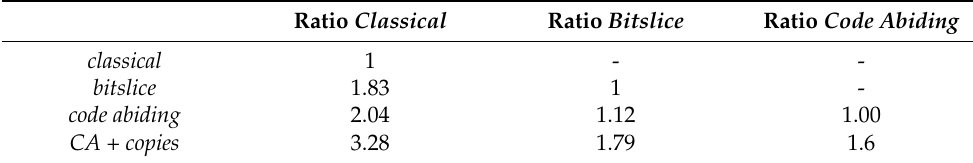
Table 5. Implementation results and cost comparison of the encryptions.